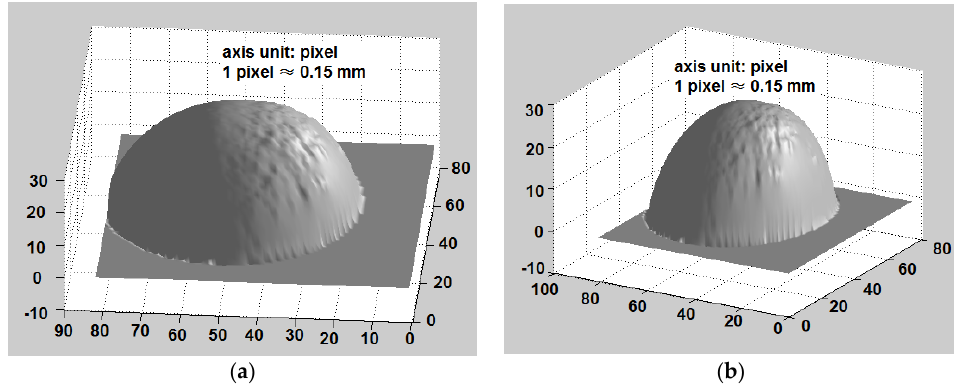
Figure 10. The 3-D reconstruction of a rigid sphere (two different view angles): ( a ) from the upper top direction, ( b ) from the right upper top direction.